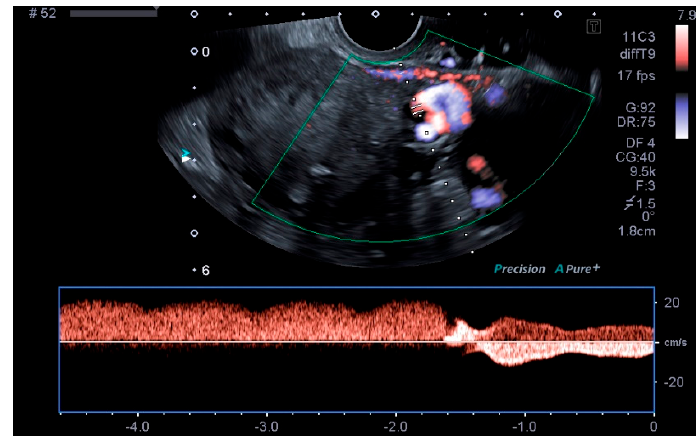
Figure 4. Reverse flow during Valsalva.